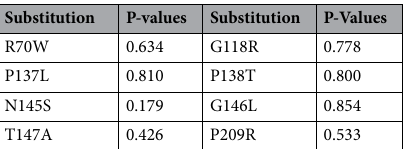
Table 1. MutPred2 P values of high risk nsSNPs identified in CTLA4.